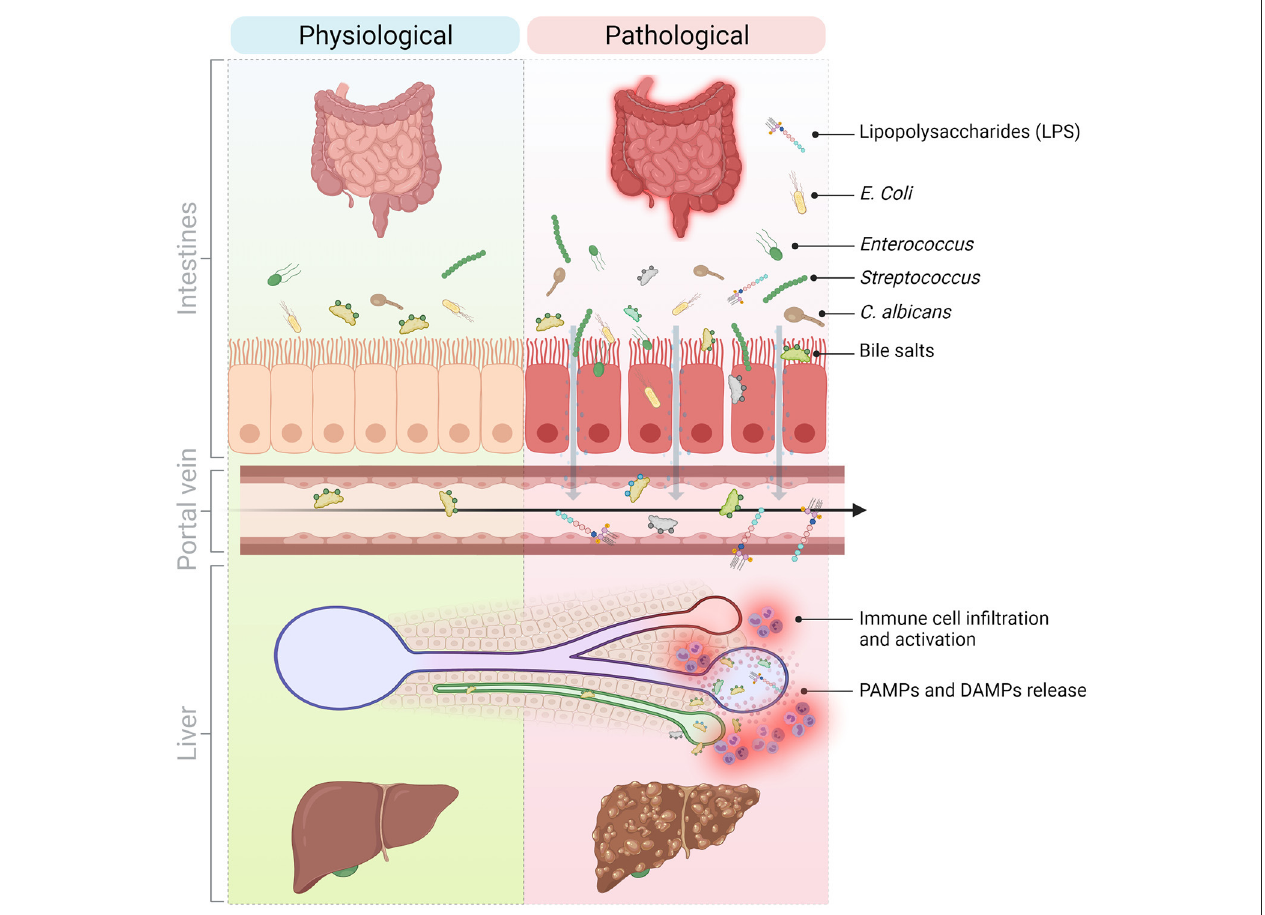
FIGURE 1 | Molecular and cellular mediators of the gut-liver axis implicated in the progression of liver inflammation in chronic liver diseases. The communication between the liver and the gut is bidirectional. The liver secretes primary bile acids and antimicrobial peptides in the bile ducts while the gut contains host-, food-, and microbiota-derived antigens and metabolites. In normal conditions, these signals contribute to maintain physiological immune cell populations in the gut and are well-tolerated by the liver. However, in pathological conditions and because of a perturbed intestinal barrier (e.g., in NASH, NAFLD, PSC), DAMPs and PAMPs originating from the intestines translocate to the liver via the hepatic portal vein and thus, promote liver injury and inflammation and sustain liver disease progression. DAMPs, Danger-associated molecular patterns; LPS, Lipopolysaccharide; NAFLD, Non-alcoholic fatty liver disease; NASH, Non-alcoholic steatohepatitis; PAMPs, Pathogen-associated molecular patterns; PSC, Primary sclerosing cholangitis. Created with